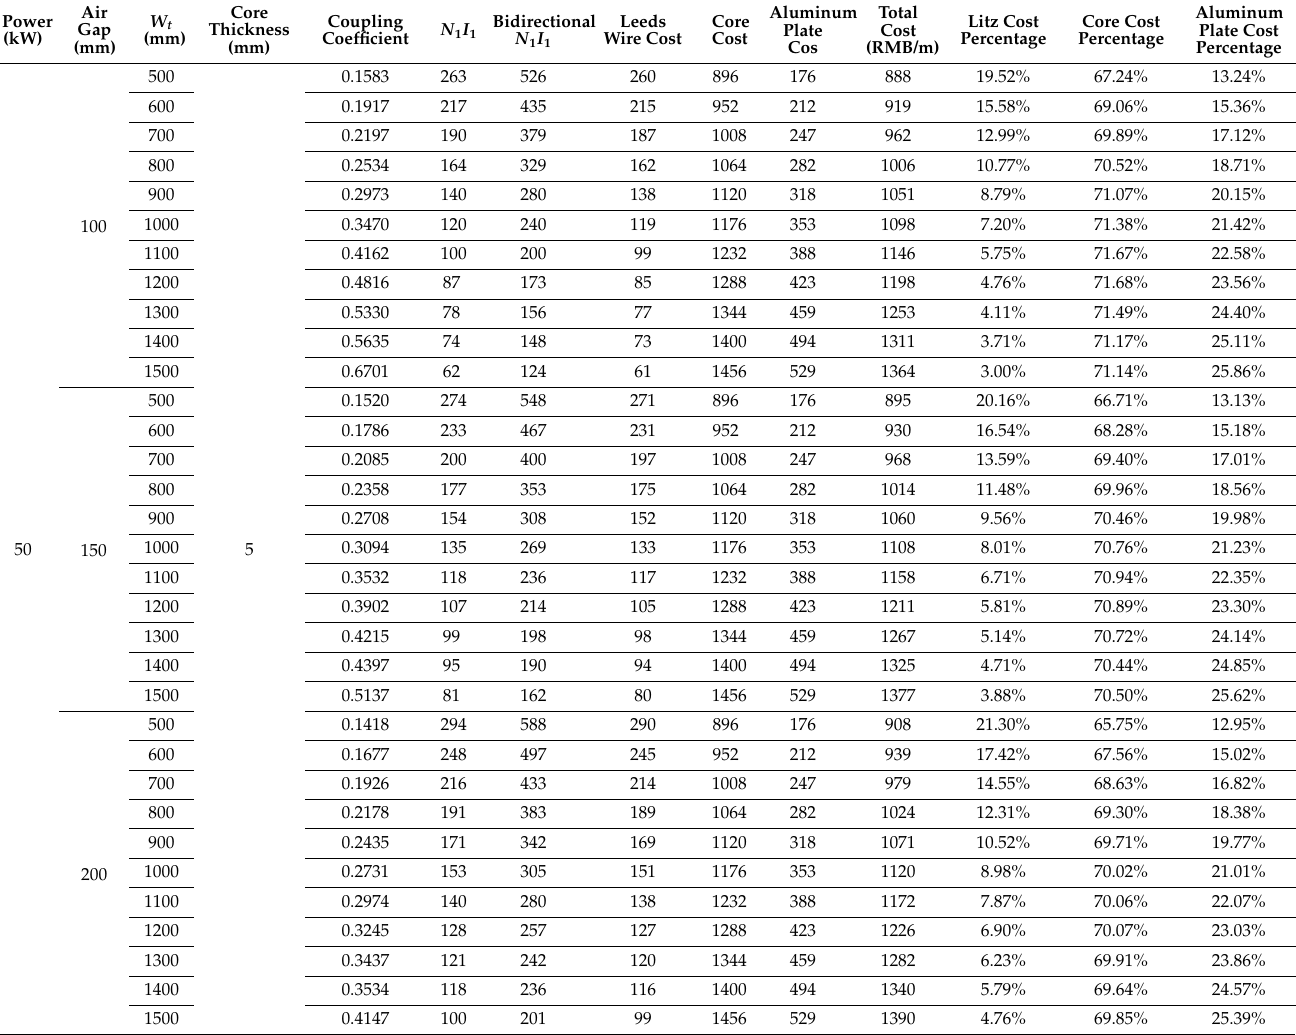
Table A1. Coil specific